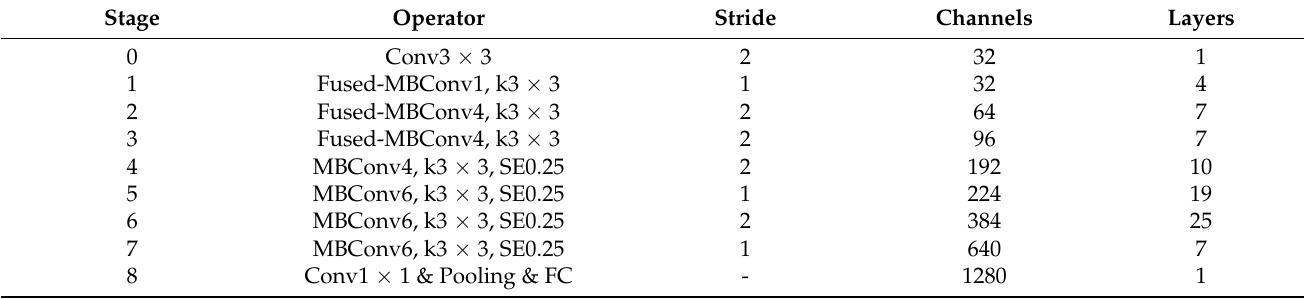
Table 1. EfficientNetV2-L architecture.